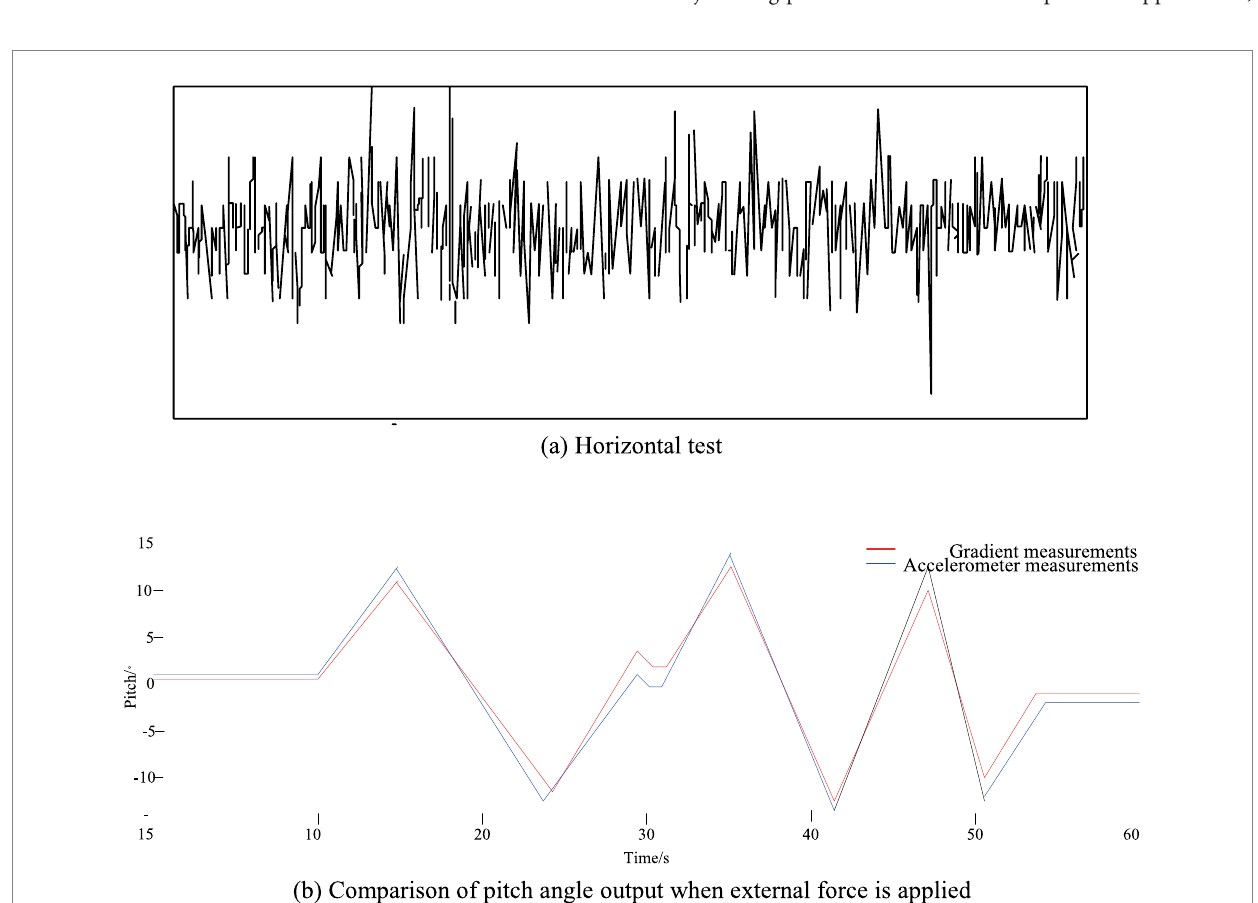
FIGURE 5 Static test. (A) Horizontal test. (B) Comparison of pitch angle output when external force is applied.